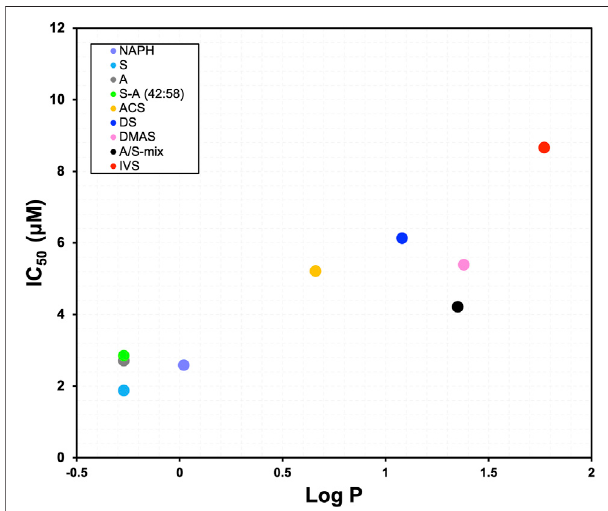
FIGURE 3 | Relationship between IC 50 values after 24 h and Log p values for the A/S derivatives [NAPH, DS, S, A, S-A (42:58), DMAS]. A/S compounds are shown in order of increasing hydrophobicity; e.g., S more hydrophilic, IVS more hydrophobic. Log p values were calculated through ChemDraw 20.0 Professional free trial (PerkinElmer Informatics Inc., 1985-2020) software, as in Ordoudi et al.